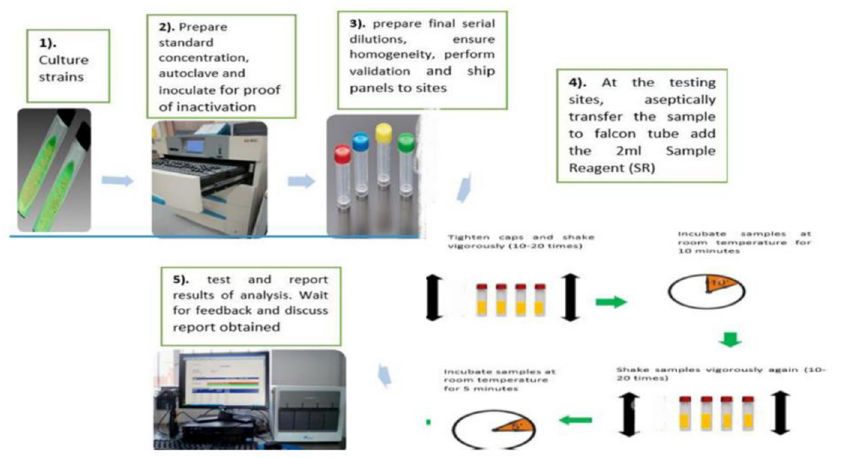
Fig 2. Procedures during the GeneXpert MTB/RIF PT preparation and testing process.